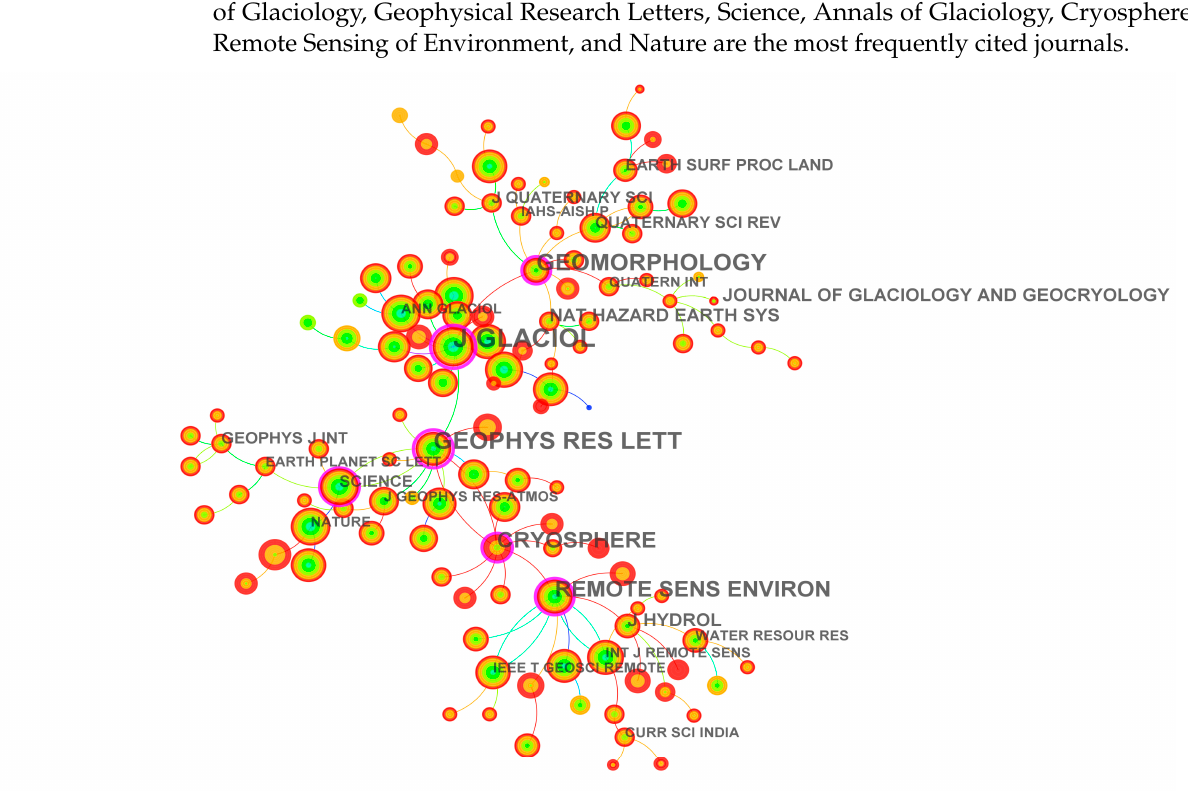
Figure 2. Knowledge map of journal collaboration. The size of each node in the journal co ‐ citation network indicates the co ‐ citation frequency of journals in the sample. The influence of the cited journals is mainly assessed by their citation frequencies.